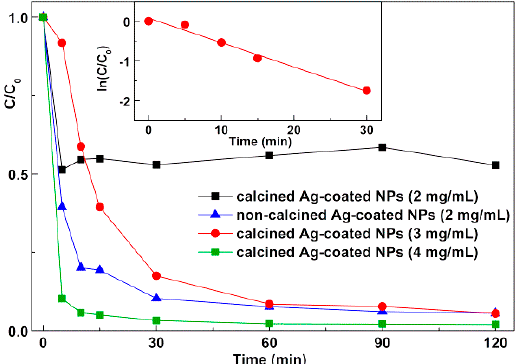
Figure 9. Photodegradation curves for Rhodamine B solution (40 mg / L) by silver-decorated zinc / calcium ferrite nanoparticles (NPs), at various concentrations. Inset: Plot of the pseudo-first-order kinetics for calcined Ag-coated nanoparticles 3 mg / mL (for the first 30 minutes).